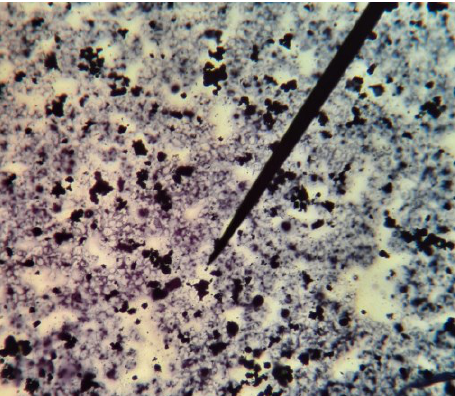
Figure 3. Bio-based polymer extracted from species 1B and stained with Sudan black .